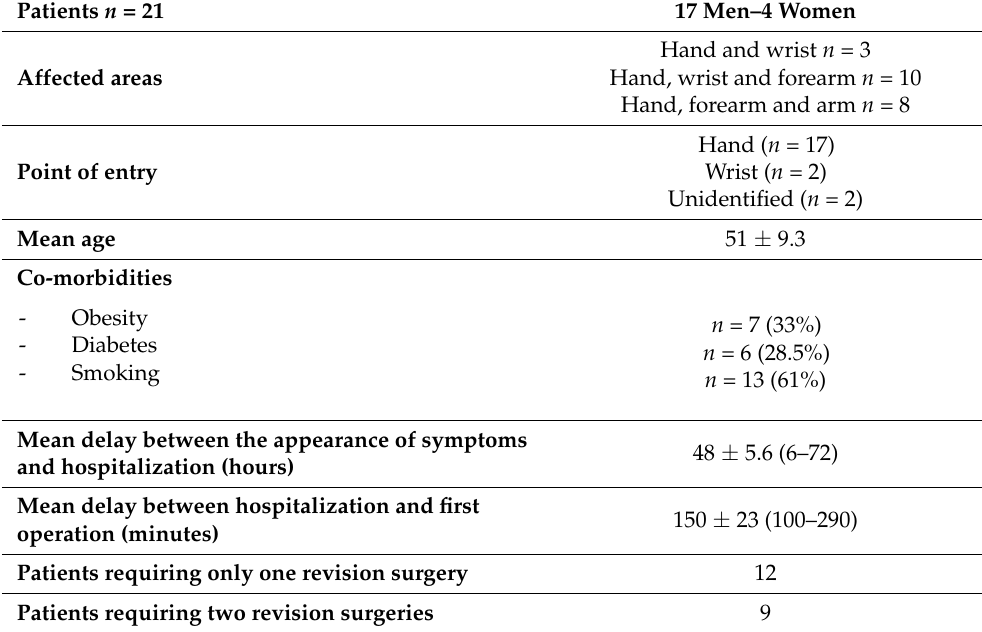
Table 1. Patient